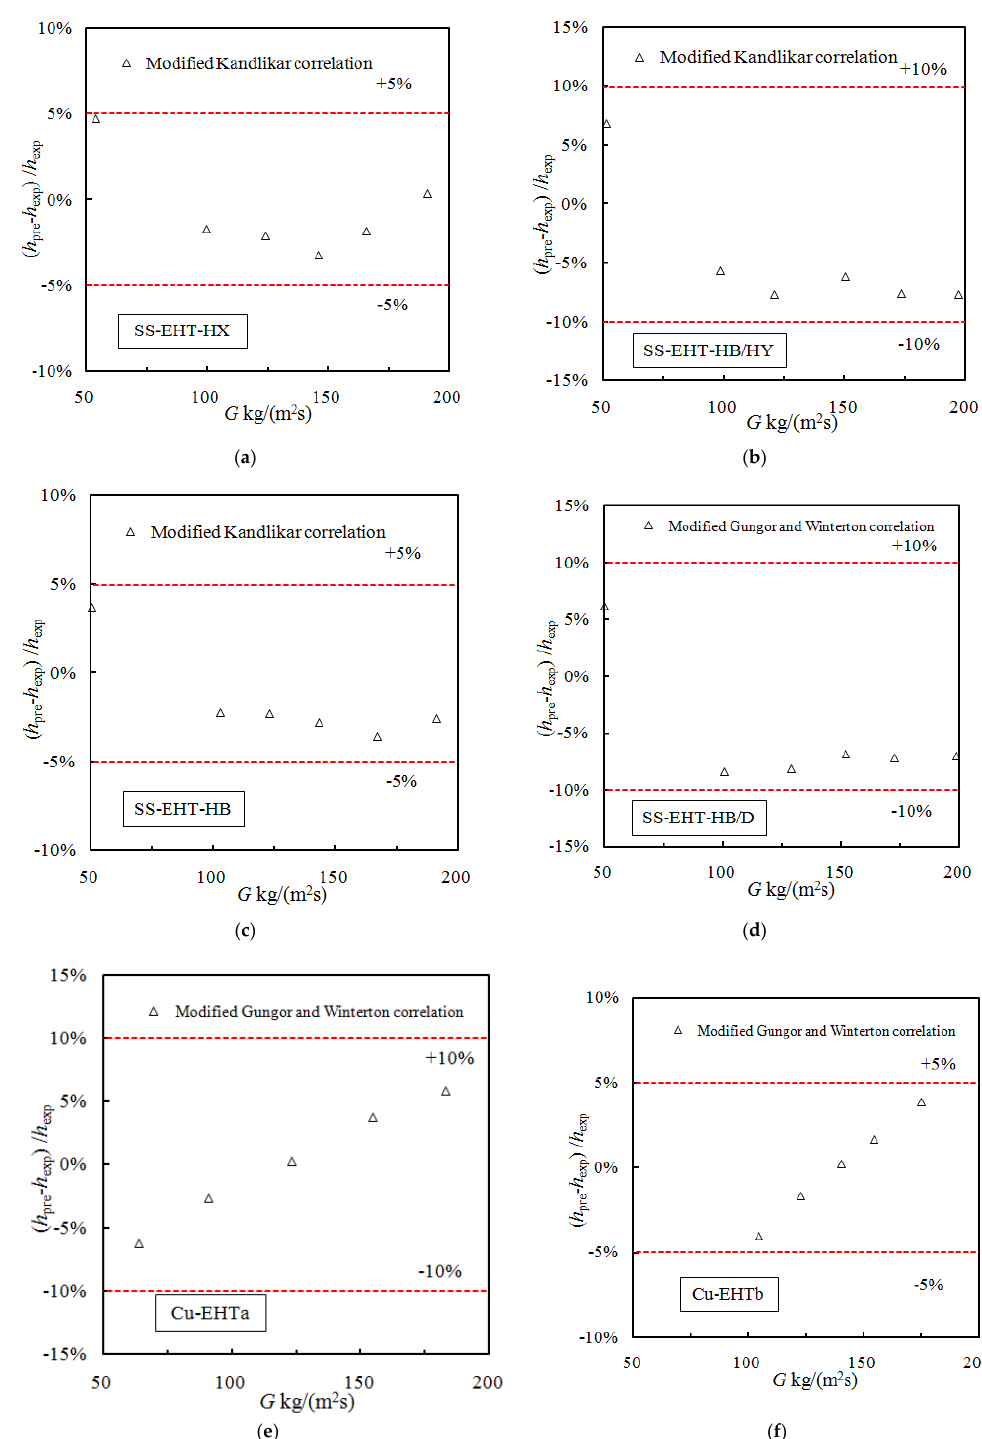
Figure 8. Comparison of the deviation of experimental data and values predicted using modified smooth tube models that can be used for enhanced tubecorrelations. ( a ) Prediction effect of the modified Kandlikar correlation for the SS-EHT-HX tube; ( b ) Prediction effect of the modified Kandlikar correlation for the SS-EHT-HB/HY tube; ( c ) Prediction effect of the modified Kandlikar correlation for the SS-EHT-HB tube; ( d ) Prediction effect of the modified Gungor and Winterton correlation for the SS-EHT-HB/D tube; ( e ) Prediction effect of the modified Gungor and Winterton correlation for the Cu-EHTa tube; ( f ) Prediction effect of the modified Gungor and Winterton correlation for the Cu-EHTb tube. The deviation of the experimental data and values predicted using the modified Gungor and Winterton correlation (see Table 3) and the modified Kandlikar correlation (see Table 3) for the evaporation heat transfer coefficient in enhanced tubes is within ±10% of the standard deviation (see Figure 8).